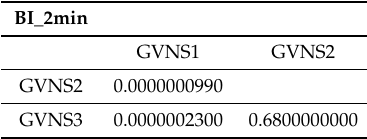
Table 16. KPairwise comparisons using Wilcoxon signed rank